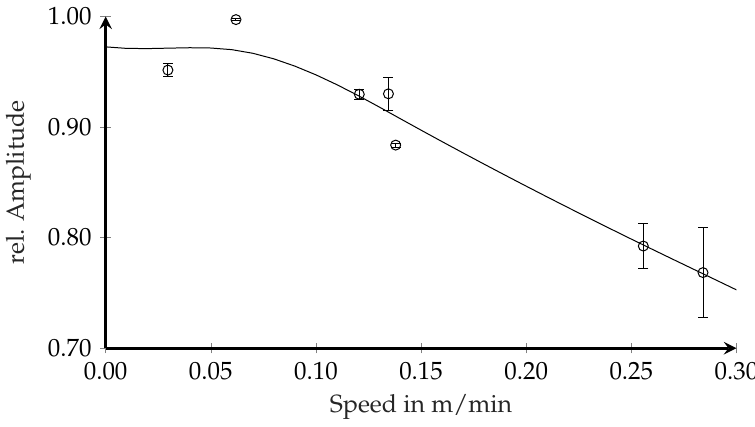
Figure 6. Correlation between speed and sensor